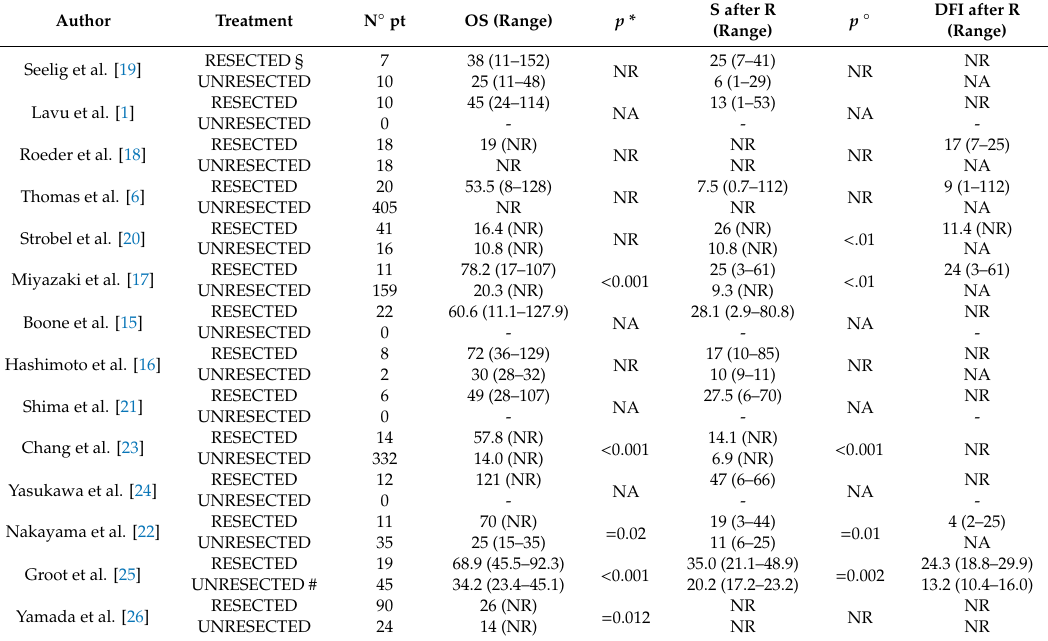
Table 3. Series reporting treatment and outcome of patients with recurrent PDAC.